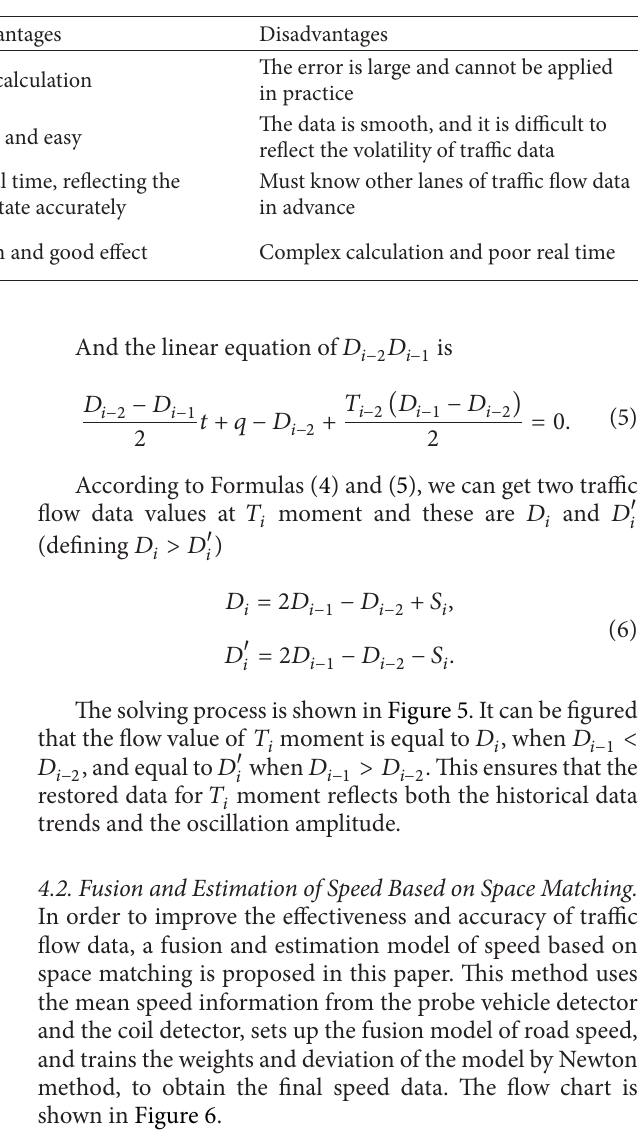
Table 2: Restoration methods comparation.